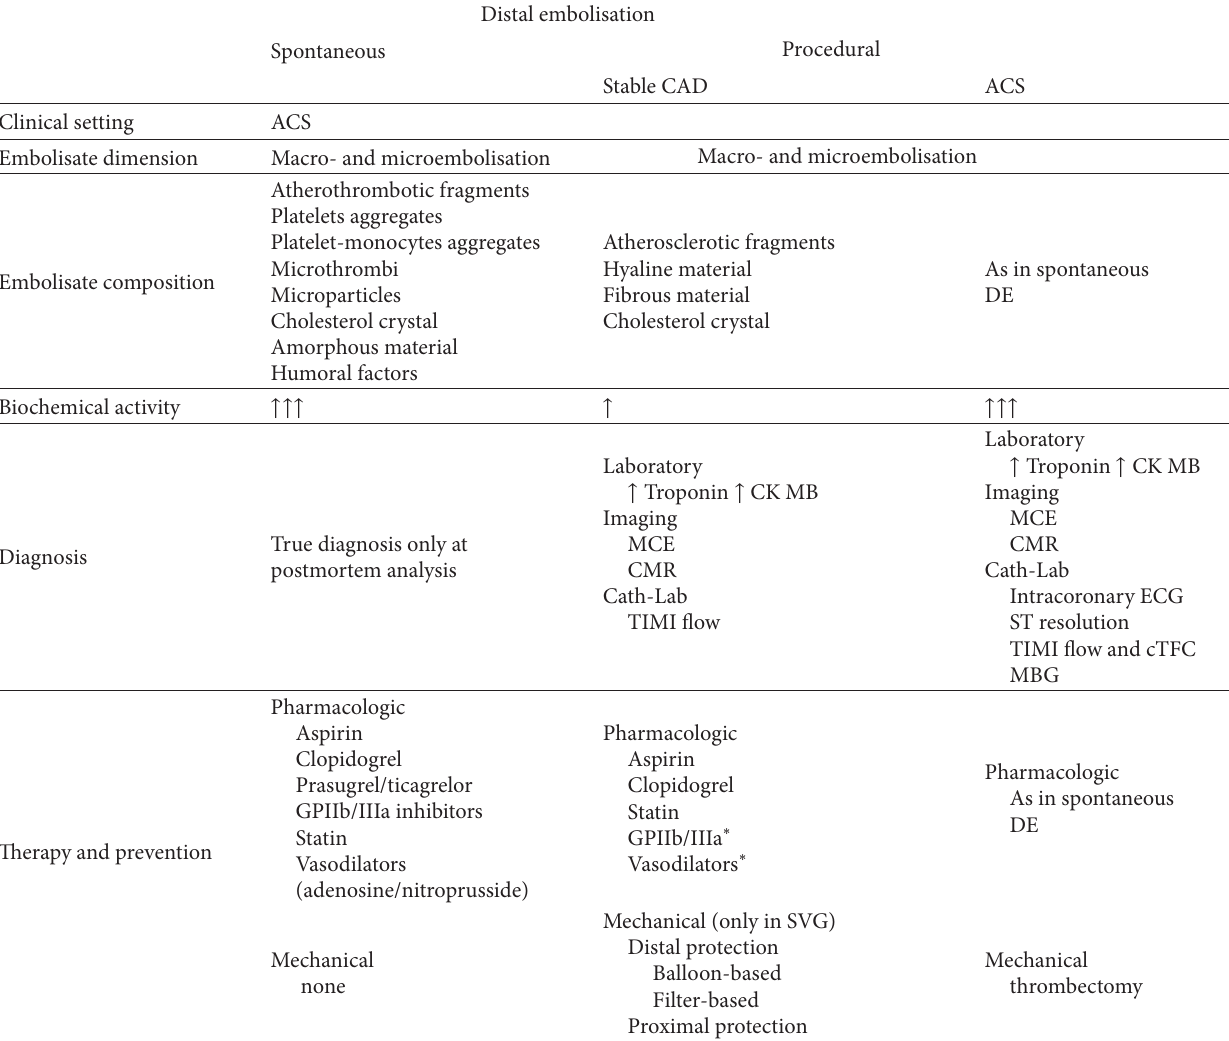
Table 1: Main differences in pathophysiology, diagnosis, and prevention of spontaneous and procedural distal